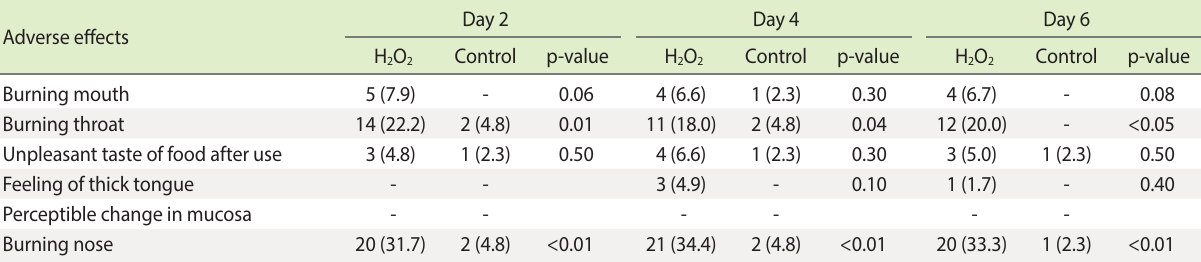
Table 4. Frequency of adverse effects on each day Adverse